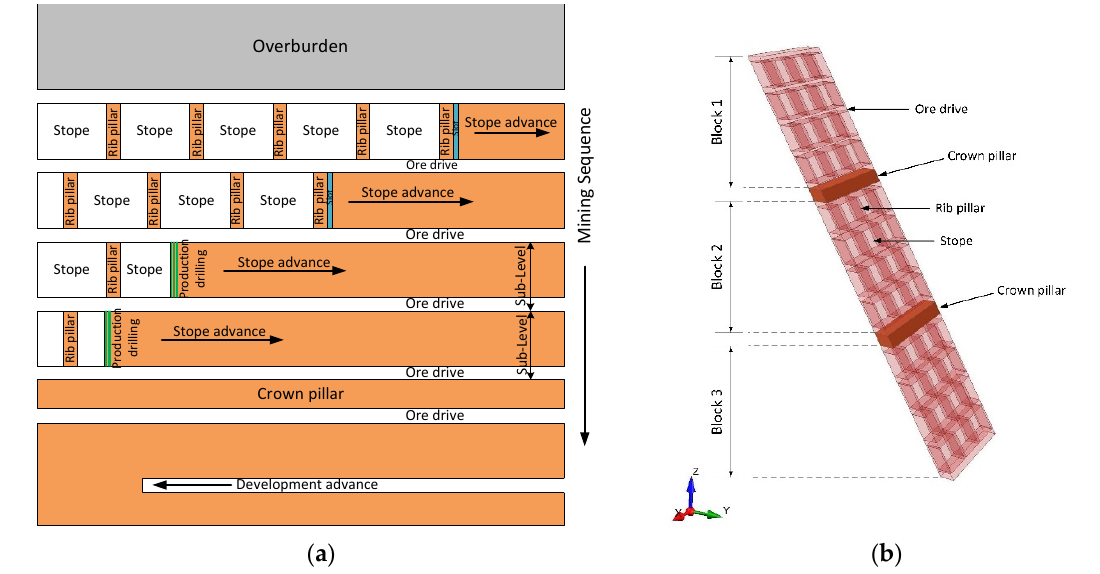
Figure 1. ( a ) Section view along strike in the SLOS mining method. ( b ) The 3D layout of the mining area.